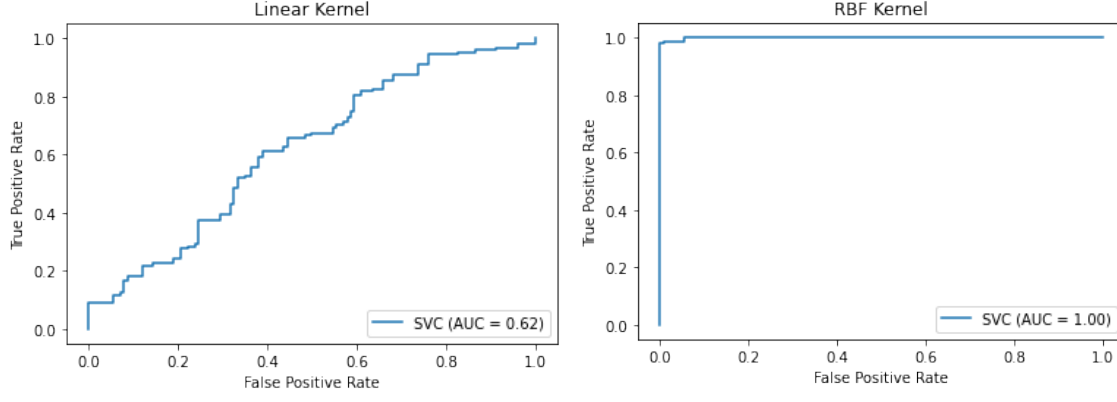
Figure B3. ROC curve of the Poly kernel Figure B2. ROC curve of the linear kernel